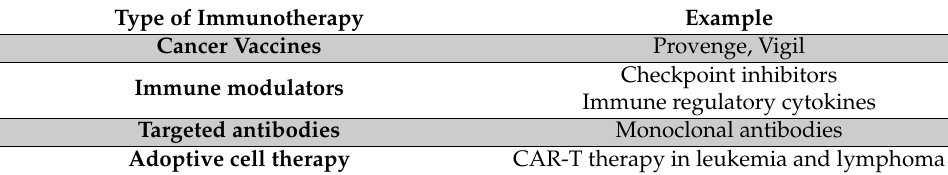
Table 1. Types of cancer